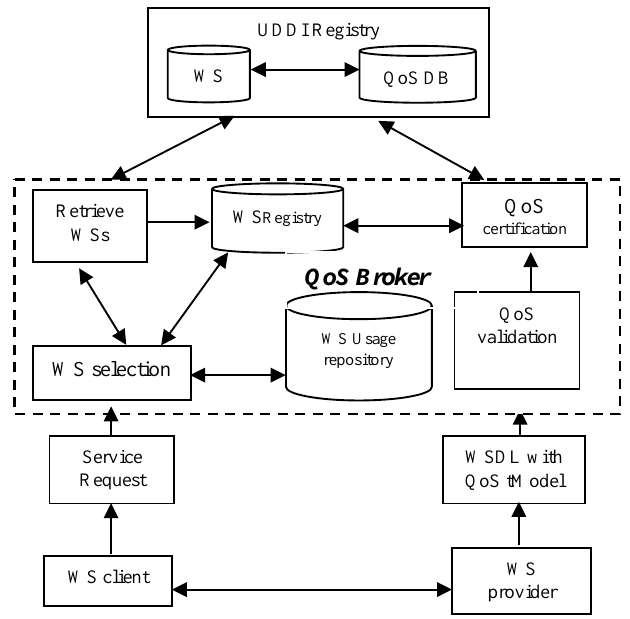
Figure 2 .QoS based web service selection Broker